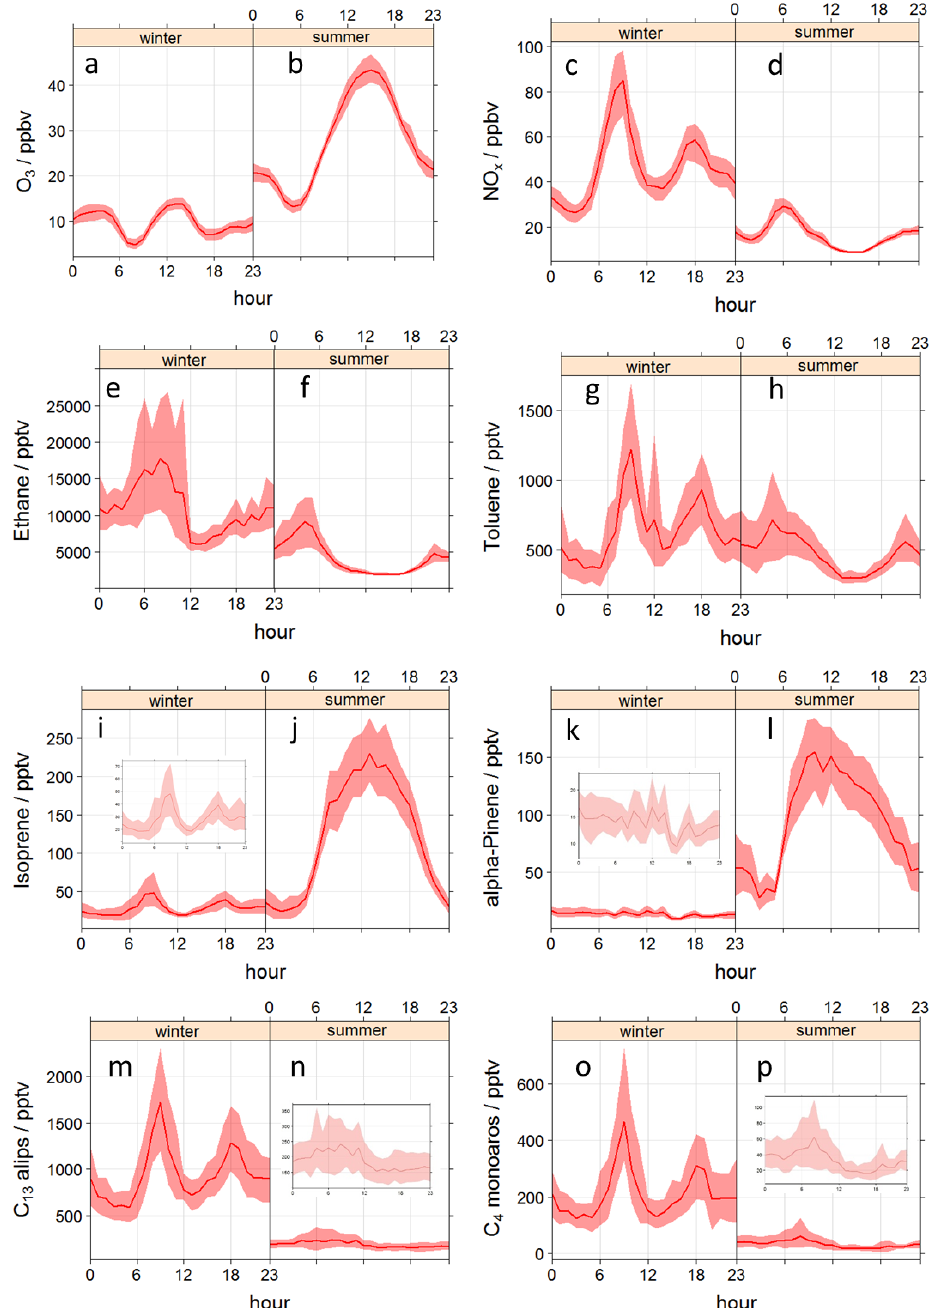
Figure 3. Diurnal profiles of selected urban pollutants in winter (left-hand side of each plot) and summer (right-hand side of each plot). Winter and summer are plotted on the same y axes to show seasonal differences, with insets allowing the profile to be easily seen. ( a and b ) Ozone ( n = 2915 and 2880; winter and summer, respectively), ( c and d ) nitrogen oxides ( n = 2915 and 2880), ( e and f ) ethane ( n = 660 and 681), ( g and h ) toluene ( n = 660 and 680), ( i and j ) isoprene ( n = 660 and 681), ( k and l ) α -pinene ( n = 691 and 634), ( m and n ) C 13 aliphatics ( n = 692 and 632), ( o and p ) C 4 substituted monoaromatics ( n = 692 and 563). Figure 3 was constructed using the OpenAir project for R where the solid line represents the mean daily concentration and the shaded regions shows the 95% confidence intervals surrounding the mean (Carslaw and Ropkins, 2012a, b; R Development Core Team,